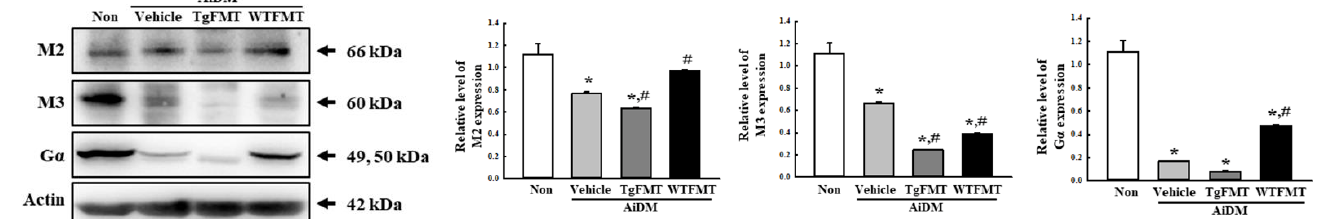
Figure 11. Levels of mAChRs expression in AiDM+TgFMT mice. mAChR M2, M3, and Gα expres- sion. The expression levels of mAChR M2, M3, and Gα were measured by western blot analysis using the specific primary antibodies and HRP-labeled anti-rabbit IgG antibody. The tissue homog- enate was prepared from three to five mice per group, and western blot analyses were performed in duplicate. The data are reported as the mean ± SD values. *, p < 0.05 compared to the Non-treated group. #, p < 0.05 compared to the AiDM+Vehicle-treated group. Abbreviations: WT, wild-type; KO, knock out; FMT, fecal microbiota transplantation; KFMT, knockout mice FMT; WFMT, wild-type mice FMT; AiDM, antibiotics-induced depletion of microbiota; AiDM-WT, AiDM wild-type mice; AiDM-KO, AiDM knockout mice.